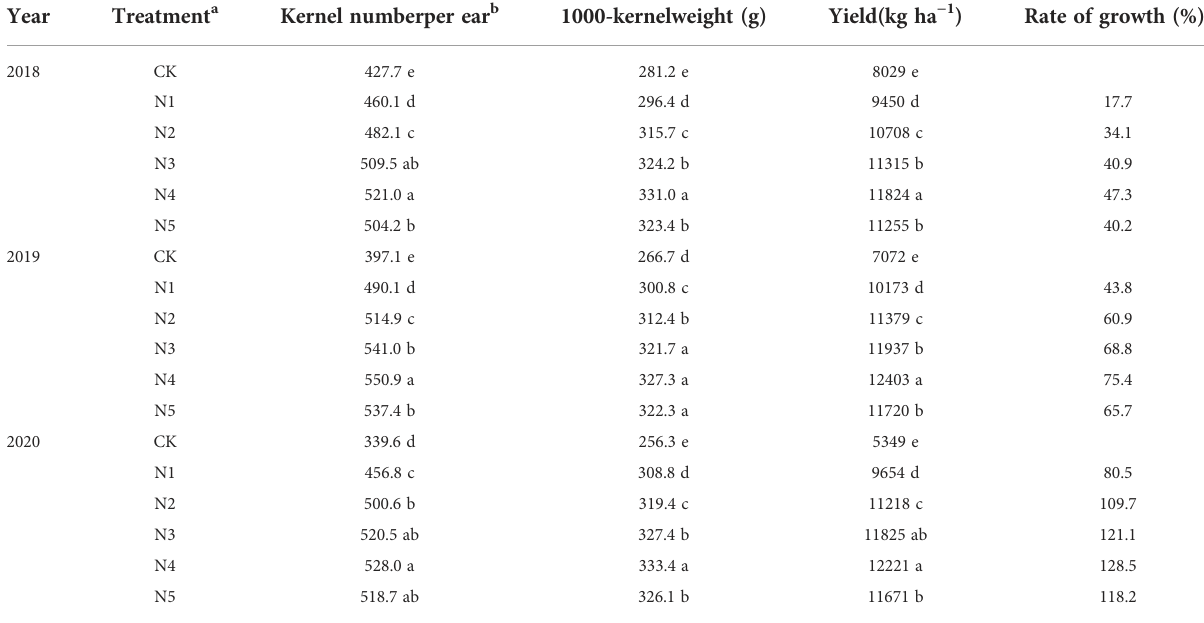
TABLE 2 Maize yield and yield components in different nitrogen (N) application